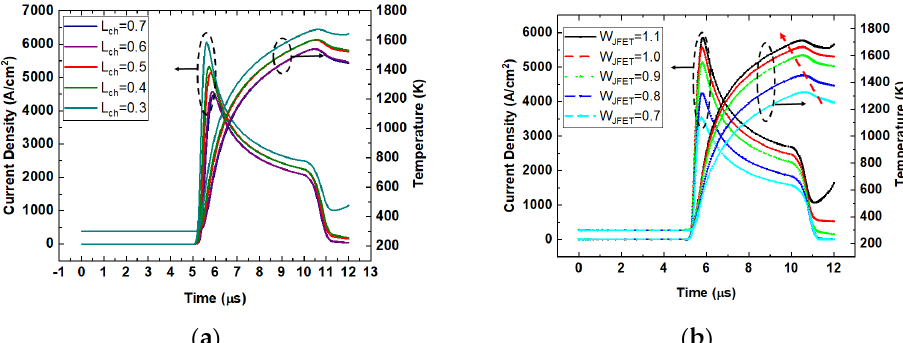
Figure 18. Output current density ( a ) with L ch variation; ( b ) W JFET variation obtained using TCAD simulations.